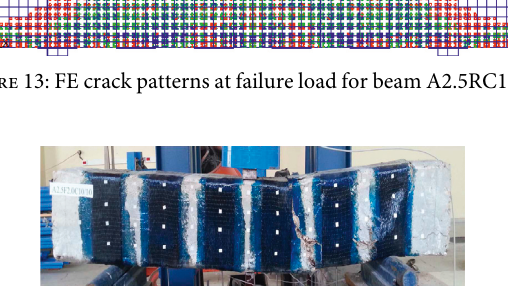
Figure 14: Experimental crack pattern at failure load for beam A2.5F2.0C10/10.